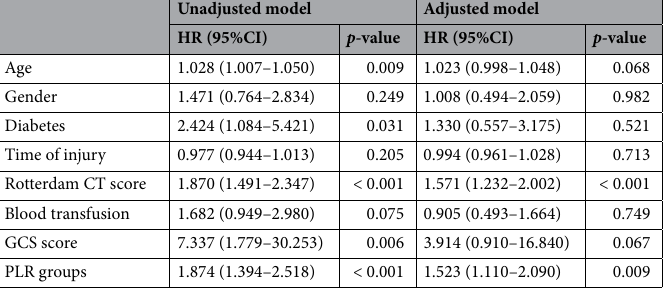
Table 3. Association of PLR level with 30-day mortality in univariate and multivariate Cox regression models.